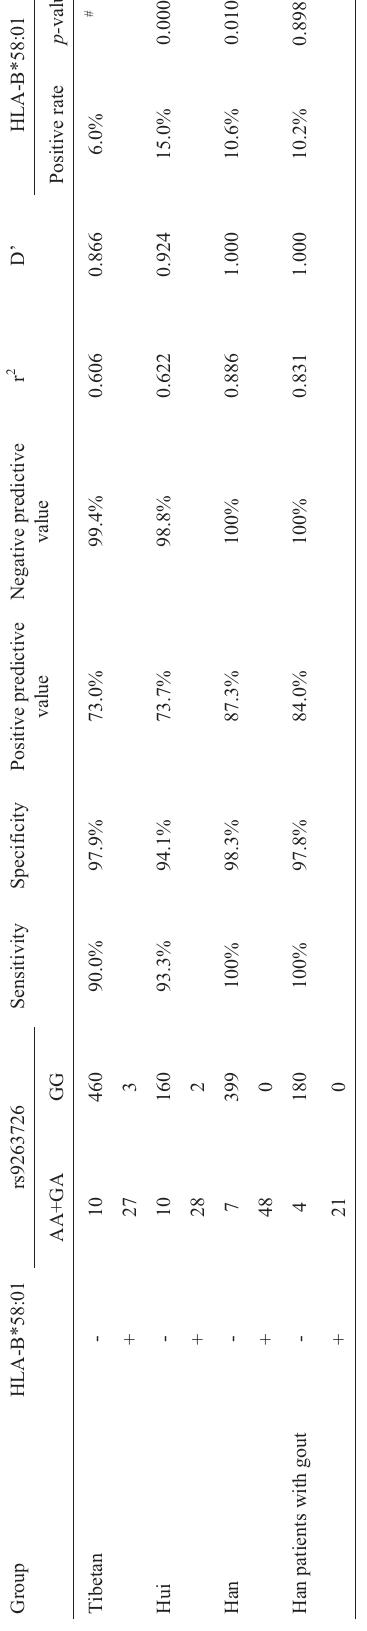
Table 3 - HLA-B genotyping for HLA-B*58:01 carriers with the GG ge- notype of rs9263726.